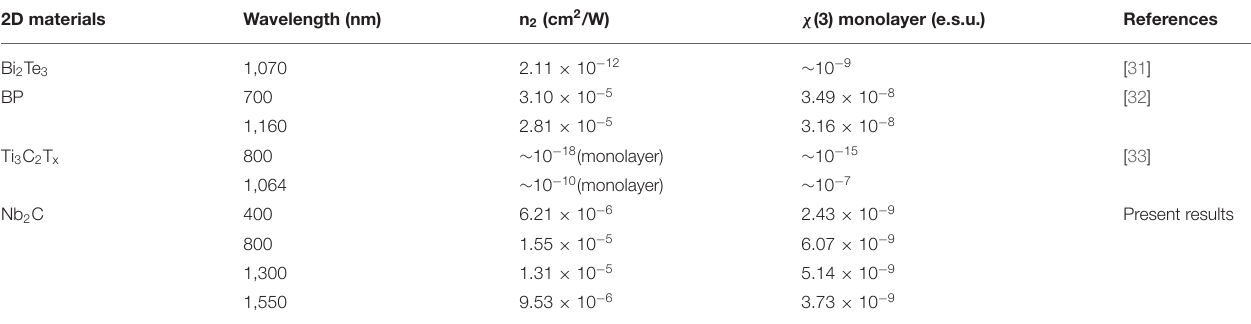
TABLE 1 | Third-Order non-linear optical parameters of different 2D materials. 2D materials Wavelength (nm) n 2 (cm 2